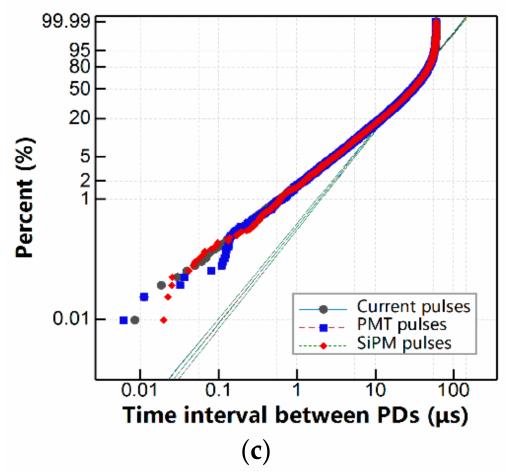
Figure 8. Weibull distributions of the time intervals between successive PD events recorded by high-frequency current transformer (HFCT), PMT, and SiPM. ( a ) Negative point discharge; ( b ) Surface discharge; and, ( c ) Floating discharge.